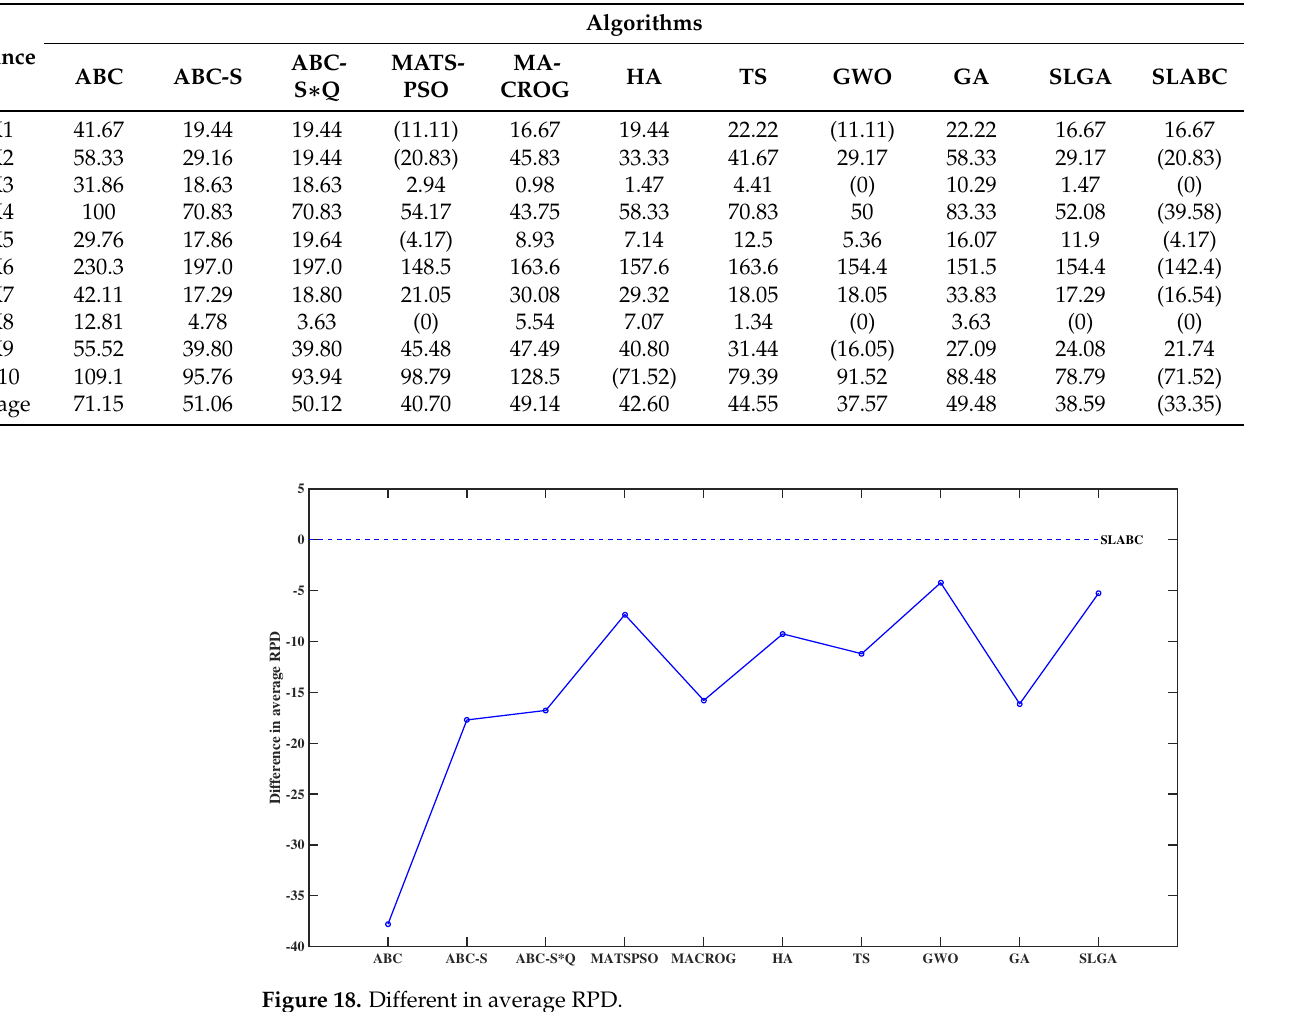
Figure 18. Different in average